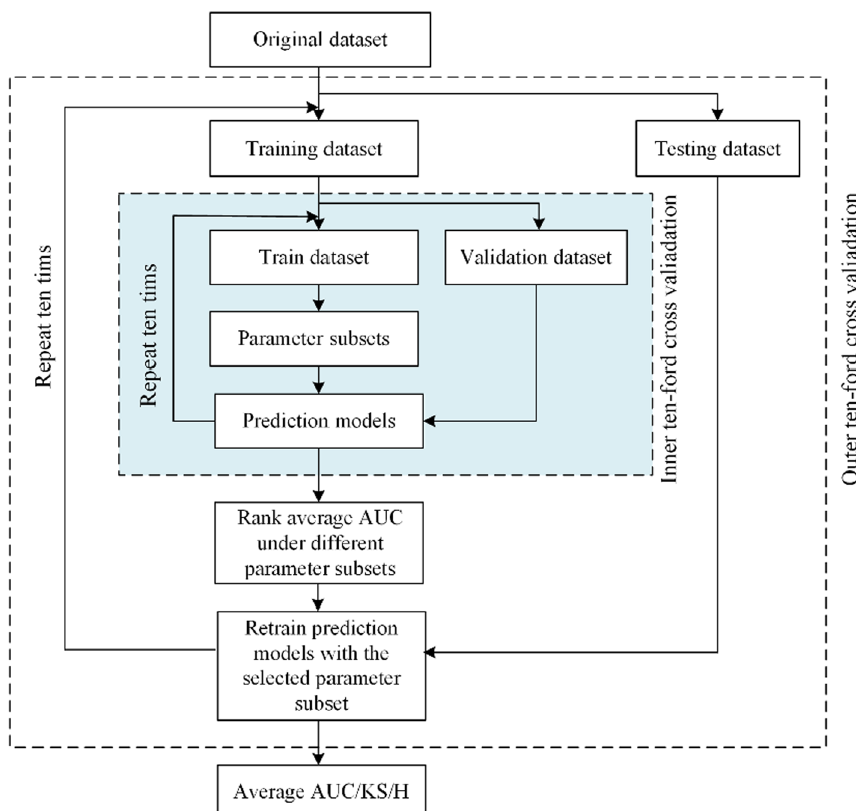
Fig. 5 Flowchart of the nested cross-validation. An inner cross-validation splitter chooses hyperparameters first, followed by an outer splitter that averages the test error over multiple training–testing